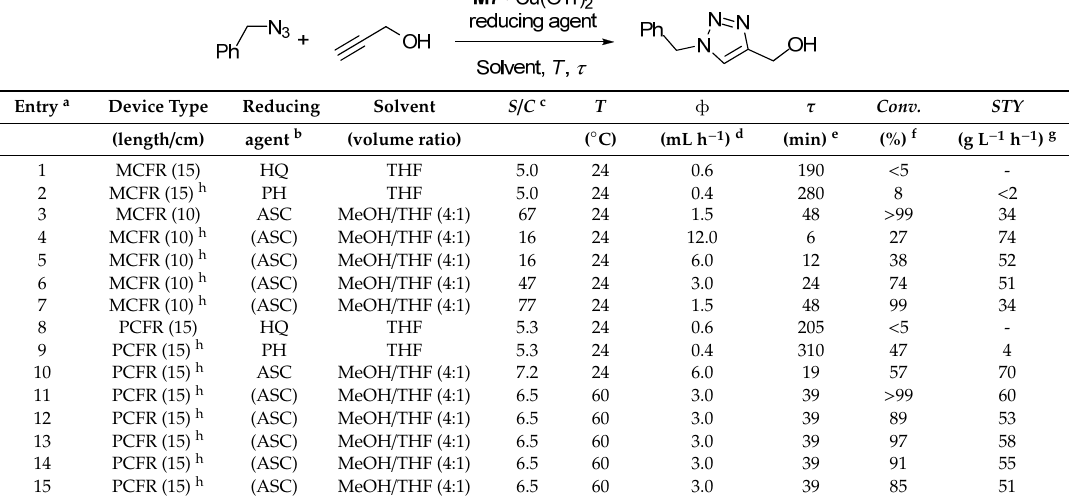
Table 2. Continuous-flow CuAAC runs in the monolithic (MCFR) and packed-bed (PCFR) devices based on reduced M7 · Cu(OTf) 2 .